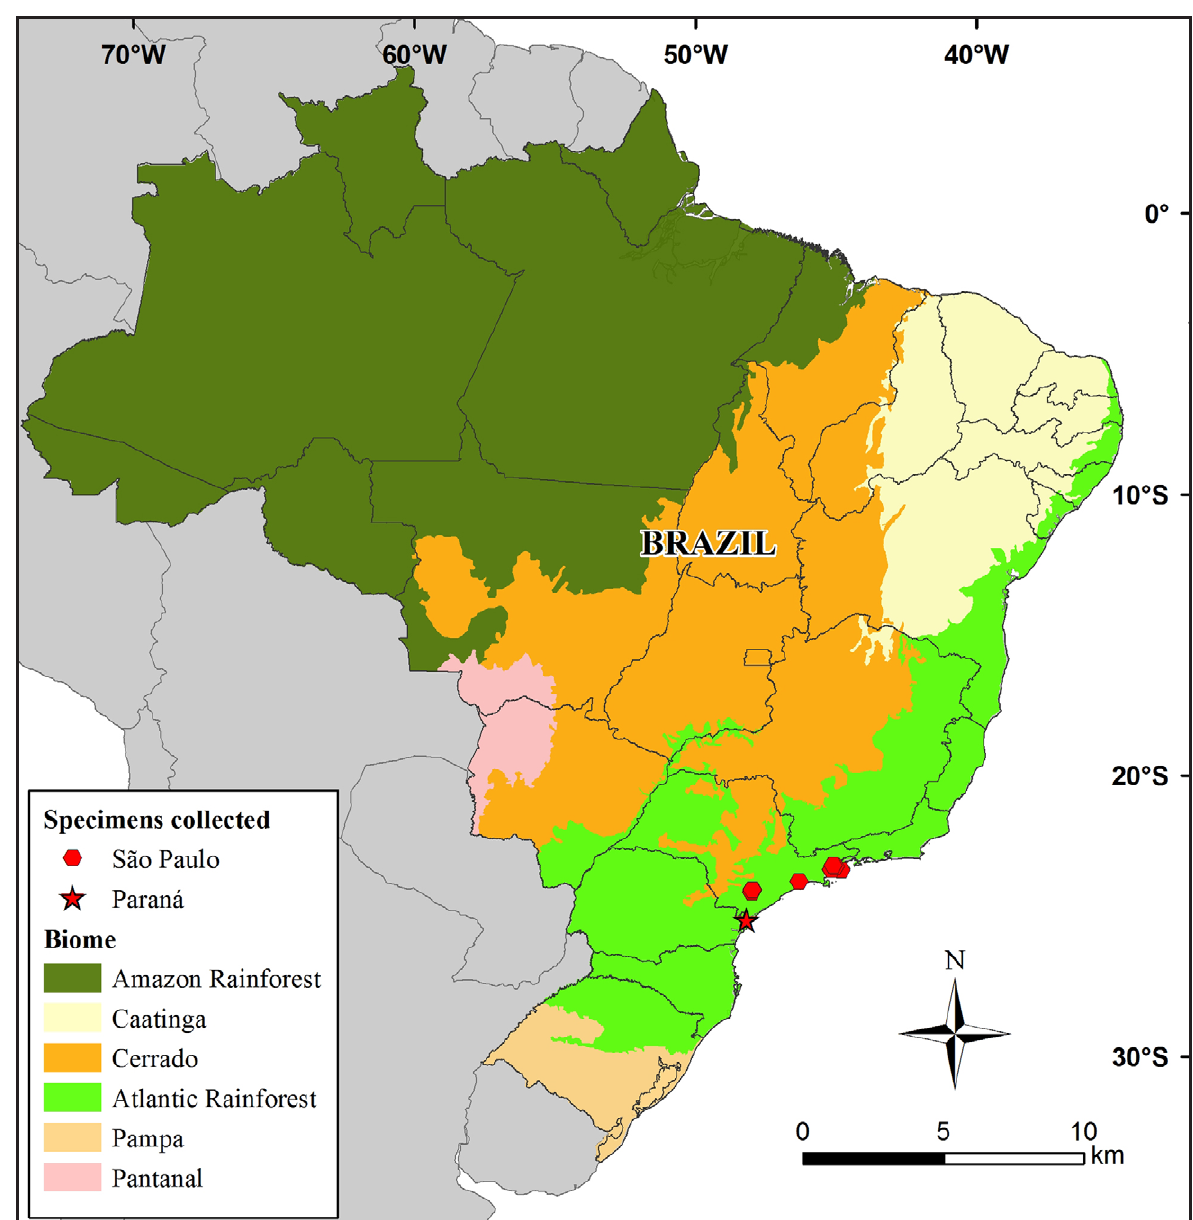
Figure 2. Distribution of Cryptocarya botelhensis